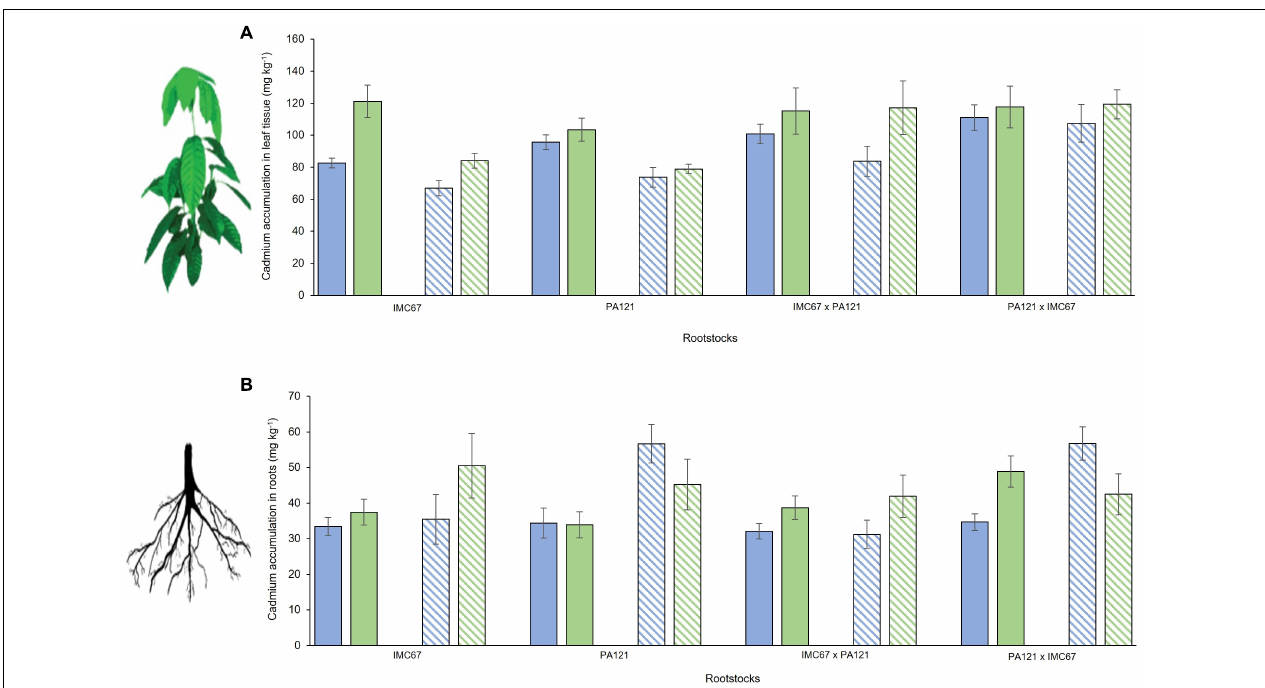
FIGURE 3 | Cadmium accumulation of ICS95 and CCN51 clonal scions grafted on four seedling rootstock families 2 and 4 months after grafting. Seedling rootstocks ( x -axis) were grown in soil enriched with Cd (7.49 mg Cd kg − 1 soil). (A) Cadmium accumulation in leaf tissue of the ICS95 and CCN51 clonal scions. (B) Cadmium accumulation in the roots of the four OP rootstock families when grafted with the ICS95 and CCN51 clones. Blue bars represent grafting combinations with ICS95 as scion 2 months after grafting. Green bars represent grafting combinations with CCN51 as scion 2 months after grafting. Data are mean values ± SE ( n = 8). Dashed bars show Cd accumulation 4 months after